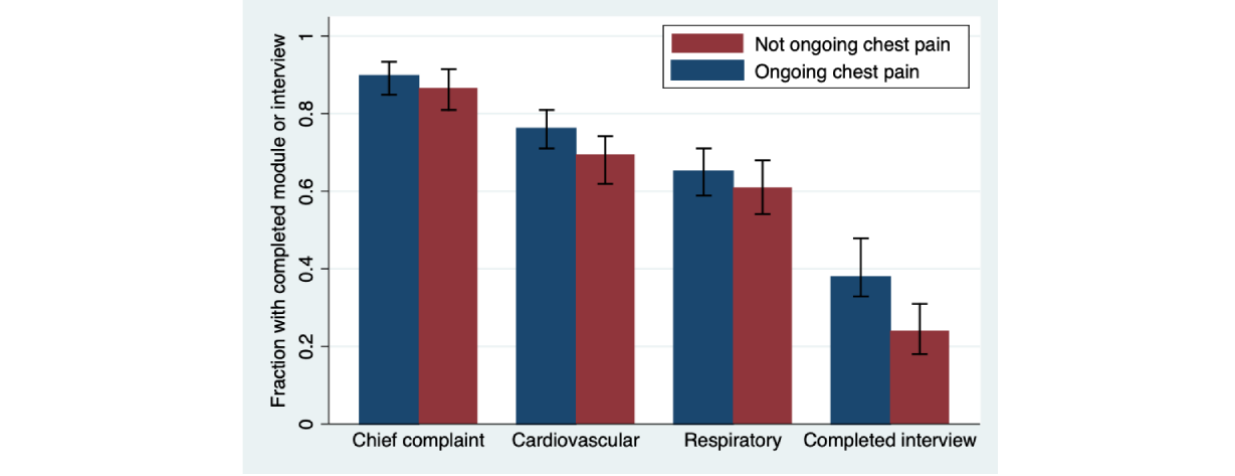
Figure 6. Fractions (with 95% CIs) of completed key modules and completed interviews, stratified by ongoing chest pain or not (264 with ongoing chest pain and 187 without).